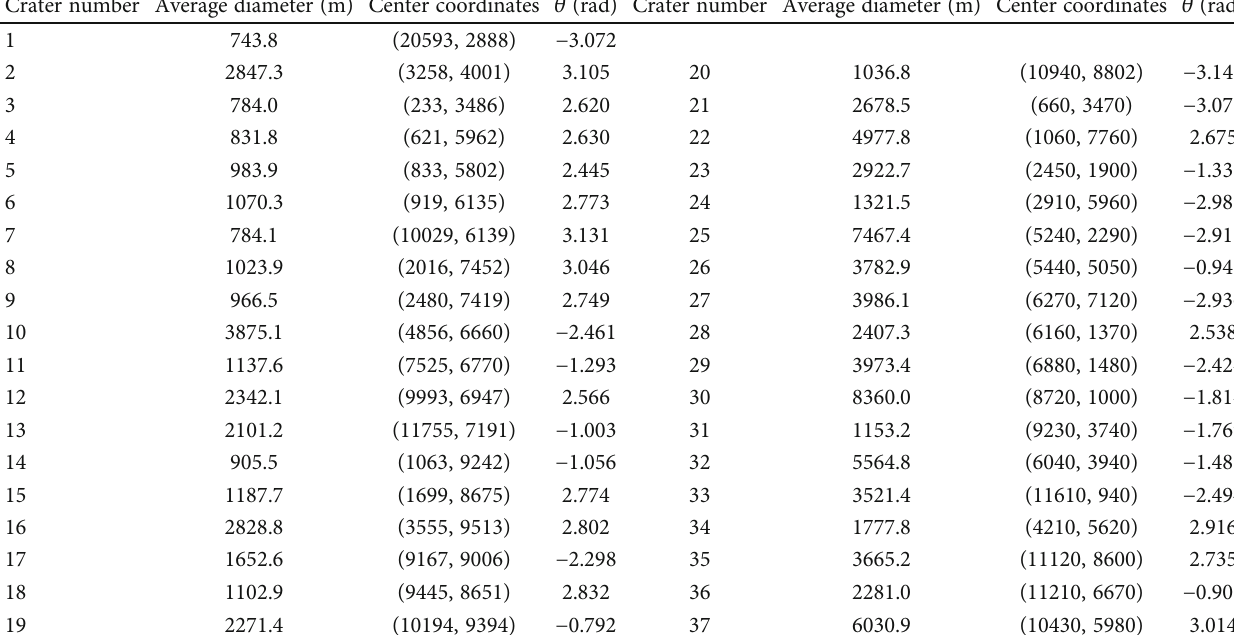
Figure 12: Ground truth including detected craters and undetected craters. Table 5: D > 700m crater extracted